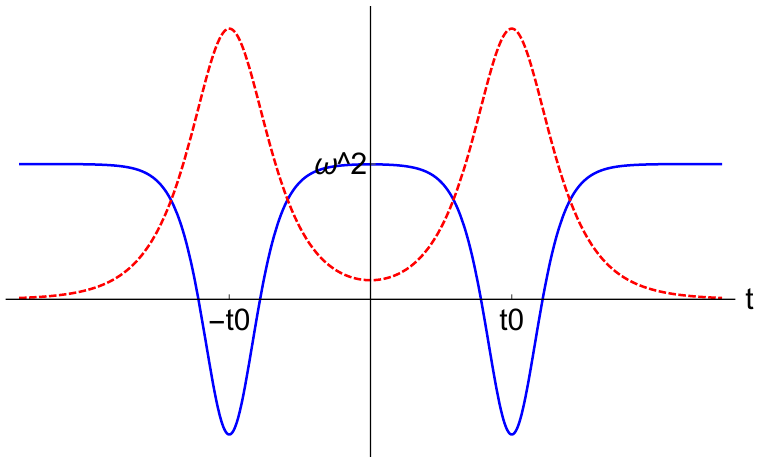
Figure 5 . Plot of the (cid:13)uctuation potential in (A.11) for the SG real bion solution (solid blue curve), together with the zero mode (dashed red curve) in (A.12). Note the double well structure of the (cid:13)uctuation potential, and the symmetric nature of the zero mode solution, characteristic of a real bion solution, leading to a positive (cid:13)uctuation